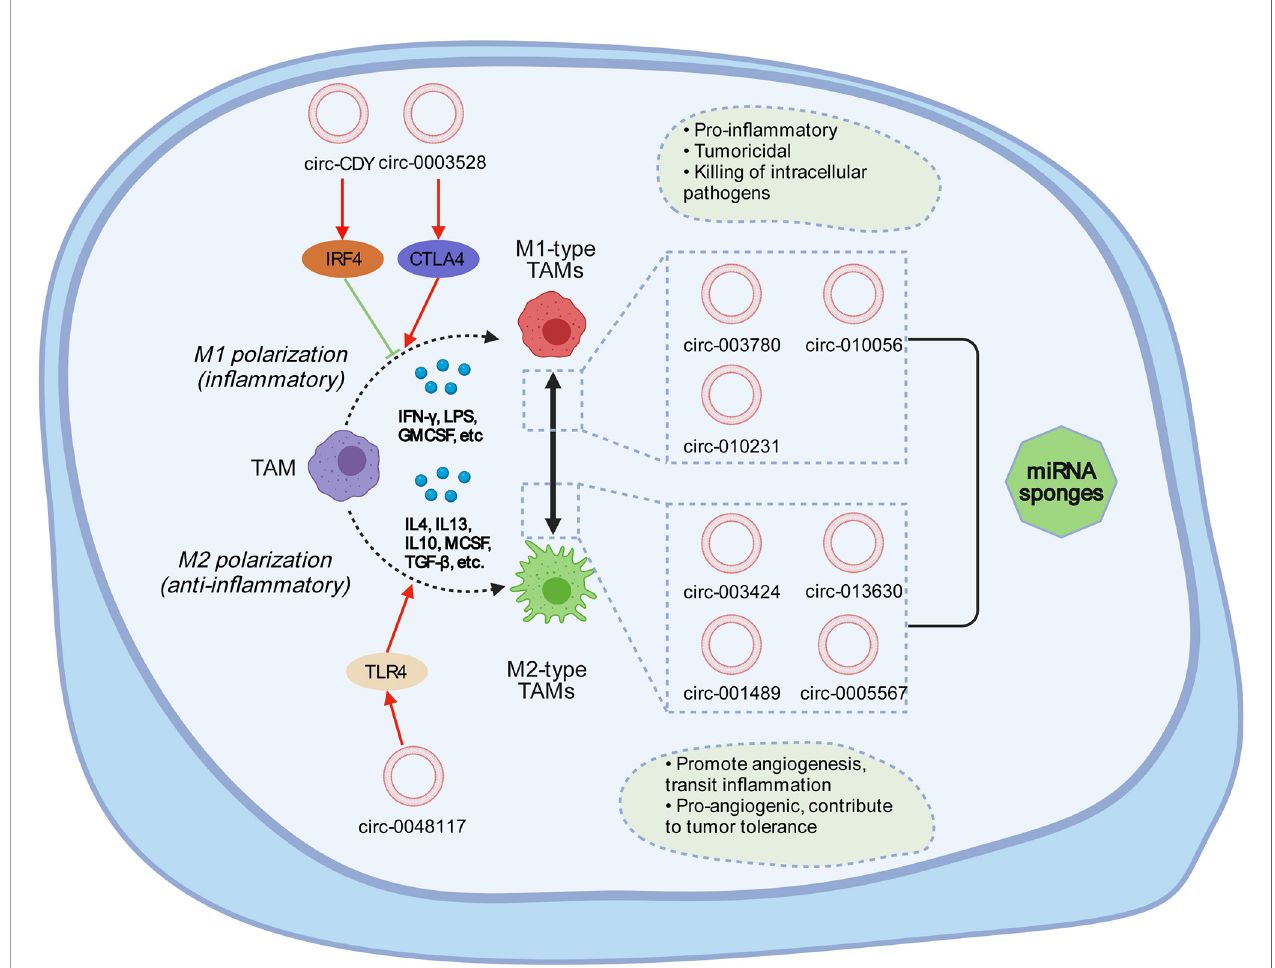
FIGURE 3 | Tumor-associated macrophages can usually be divided into M1 type and M2 type. M1 macrophages are generally activated through interferon- g and lipopolysaccharides, which mainly secrete pro-in fl ammatory factors and play a vital role in the early stage of in fl ammation. M2 macrophages are activated by Th2 cytokines, such as IL-4, IL-13, and the immune complex, express and inhibit the in fl ammatory factors, and play a role in inhibiting in fl ammatory response and tissue repair. circRNA can affect the mutual transformation between M1 and M2. circRNA-0003528 induces M1 macrophage polarization by activating CTLA4. circRNA- 0048117 promotes the polarization of M1 to M2 macrophages by promoting the expression of TLR4. circ-Cdy can affect M1 polarization through IRF4. In M1 polarization, the expressions of circ-003780, circ-010056, and circ-010231 are upregulated, while the expressions of circ-003424, circ-013630, and circ-001489 are downregulated; the opposite is true for M2 polarization. circ-0005567 can inhibit M1 polarization and promote